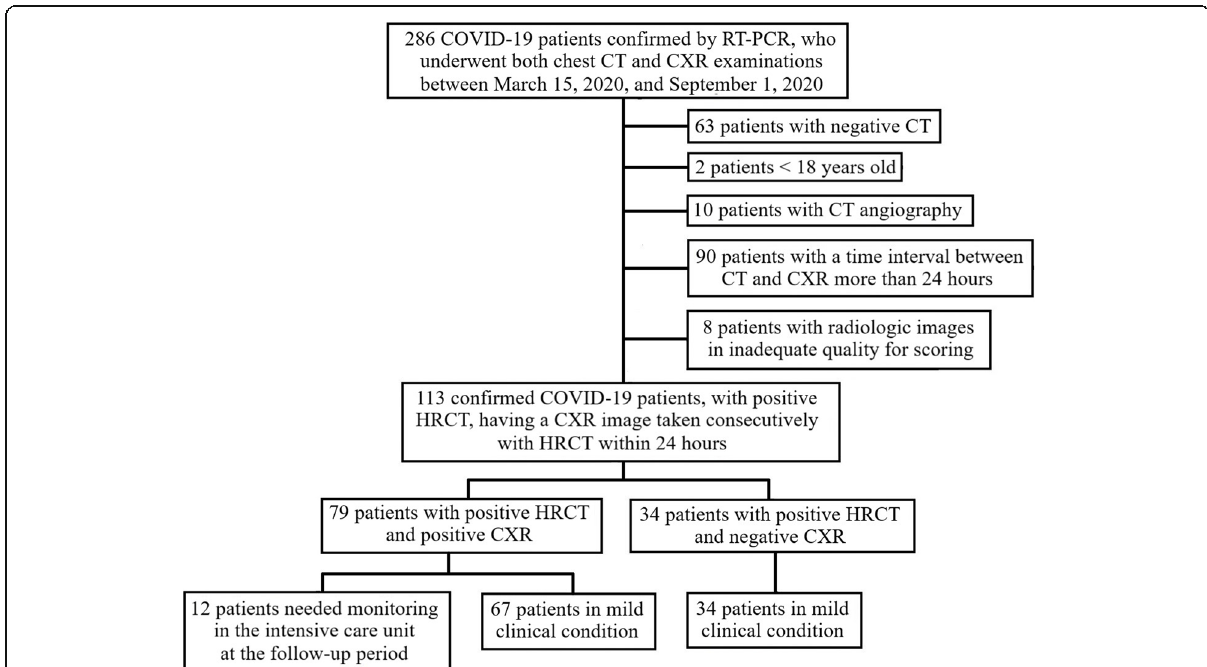
Fig. 1 Flowchart of the patient selection. CXR chest X-ray, CT computed tomography, COVID - 19 Coronavirus disease 2019, HRCT high-resolution